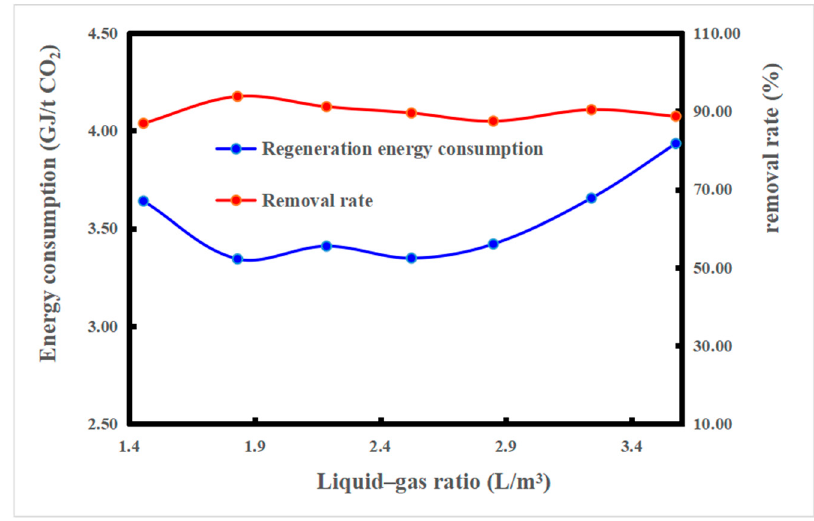
Figure 5. Effect of the liquid–gas ratio on the regeneration energy consumption and removal rate.